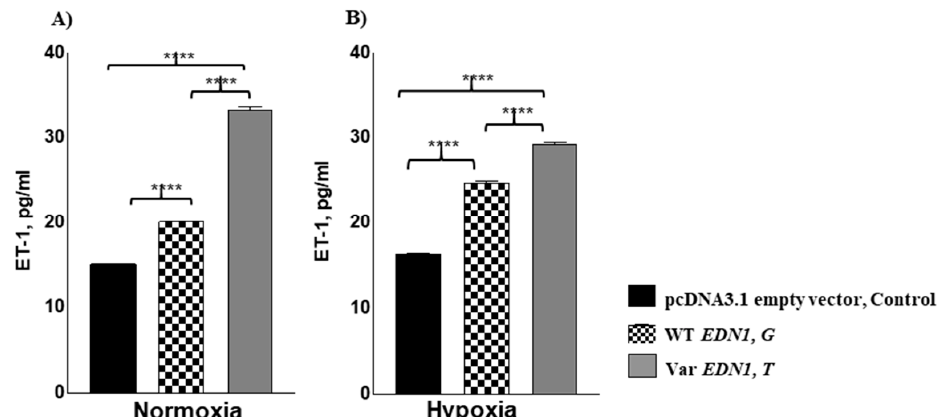
Figure 3. Both hypoxia and EDN1 rs5370 T /Asn198 variant enhanced cellular ET1 levels. HEK293 cells were either transfected with one µ g of pcDNA3.1 empty vector, control, or one µ g of WT EDN1 G allele expressing plasmid or with one µ g of Var EDN1 T allele expressing plasmid. Each of the transfected cells was either kept under ( A ) normoxic conditions for 30 h or ( B ) normoxia for 6 h, followed by hypoxic conditions (100 Μ m CoCl 2 ) for 24 h. Secreted ET-1 levels were highest in the presence of the risk T allele under normoxia and hypoxia. Data are presented as mean ± SE and are compared by a two-tailed t -test. **** p < 0.0001. WT, wild-type allele; Var, variant-type allele; SE, standard error.